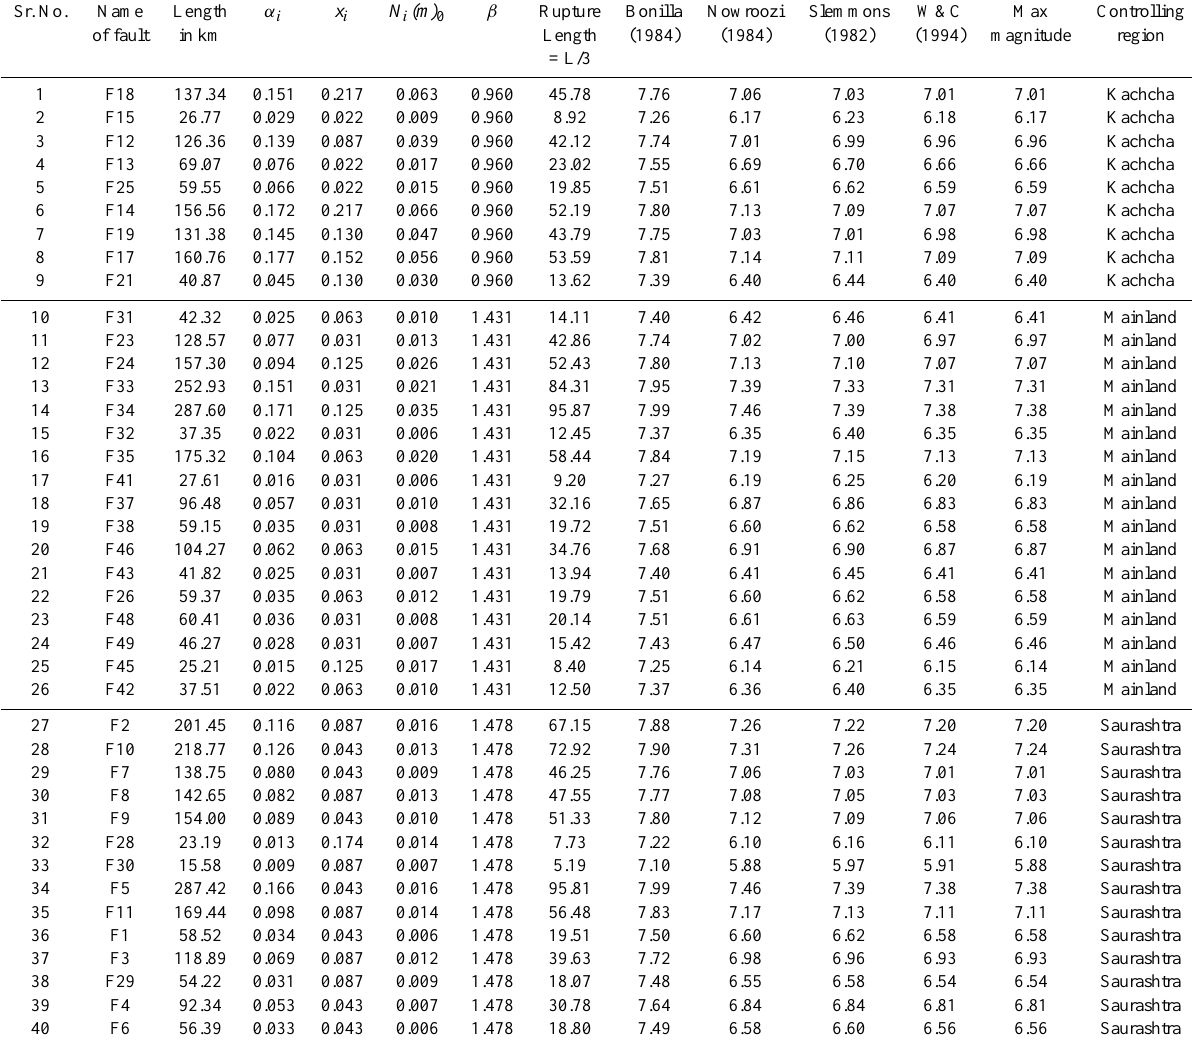
Table 2. Fault characteristics, weighting functions and maximum magnitude for faults used in Seismic Hazard Calculations. Sr.